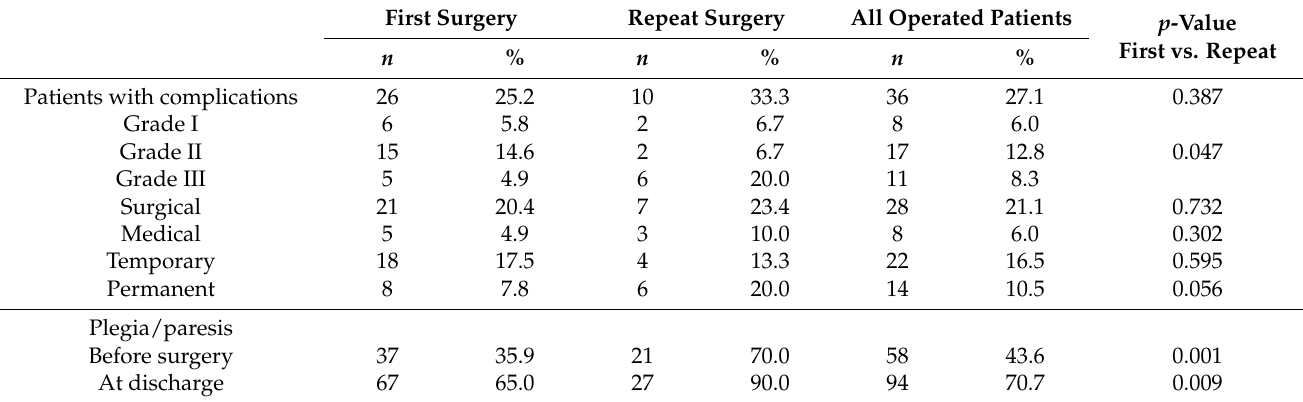
Table 3. Complications (the Landriel Ibañez classification) and motor